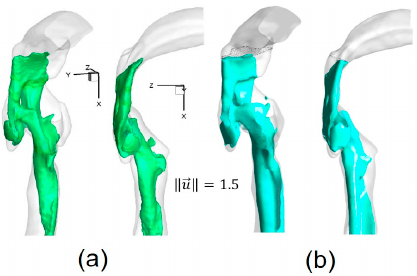
Figure 5. Iso-surfaces of velocity magnitude highlighting the structure of the epiglottal and laryngeal jets: ( a ) Experimental measurement (Reprinted from Reference [11], with permission from Springer); ( b ) Numerical simulation.